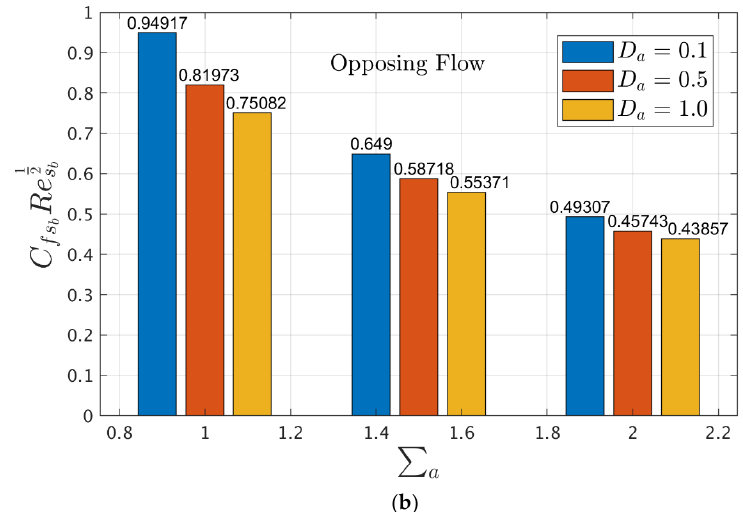
Figure 11. The bar graph represents the shear stress against Σ a for the case of ( a ) assisting flow and ( b ) opposing flow with various values of the curvature parameter radius.